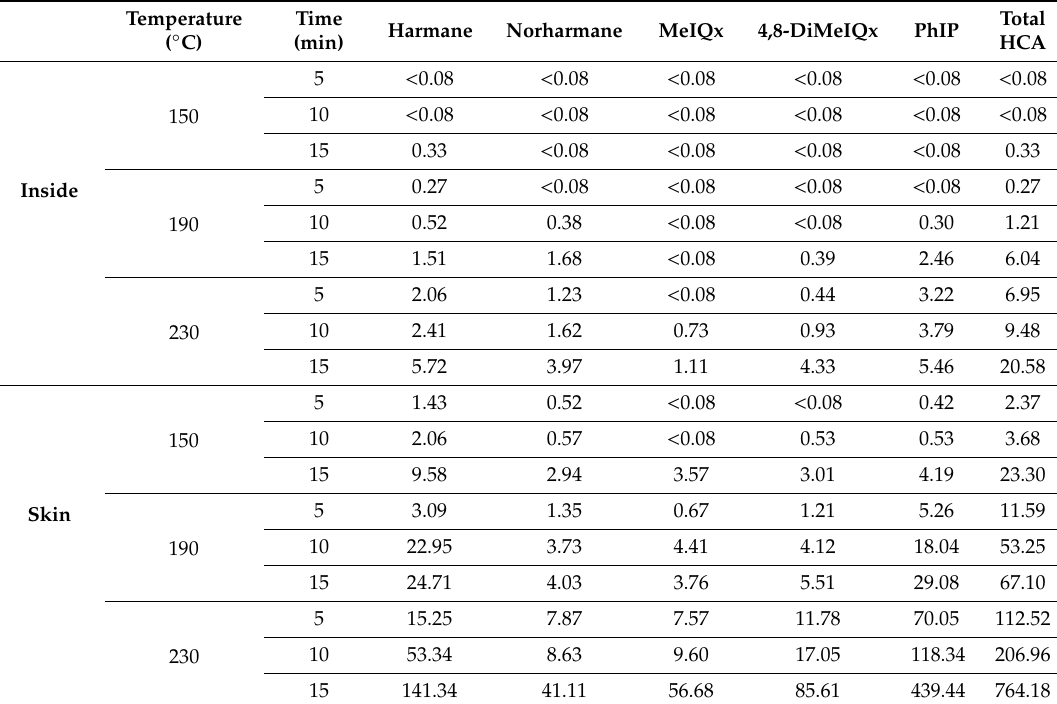
Table 3. Heterocyclic amine content of samples with skin, grilled closed (ng / g).